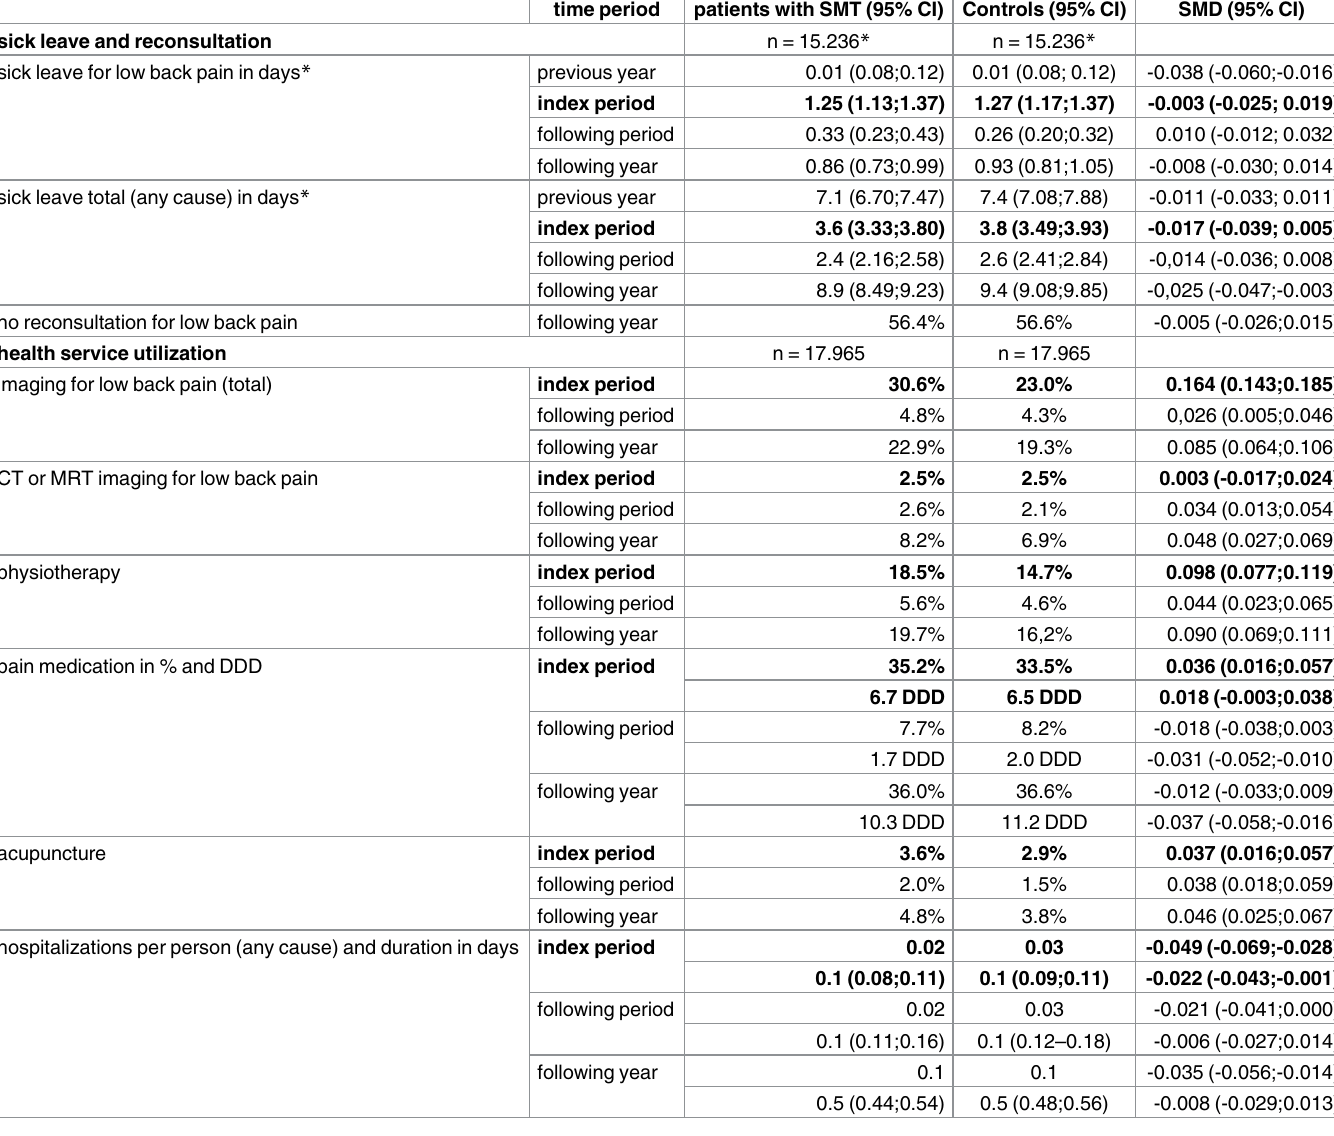
Table 2. Comparison of outcomes of patients treated with and without spinal manual